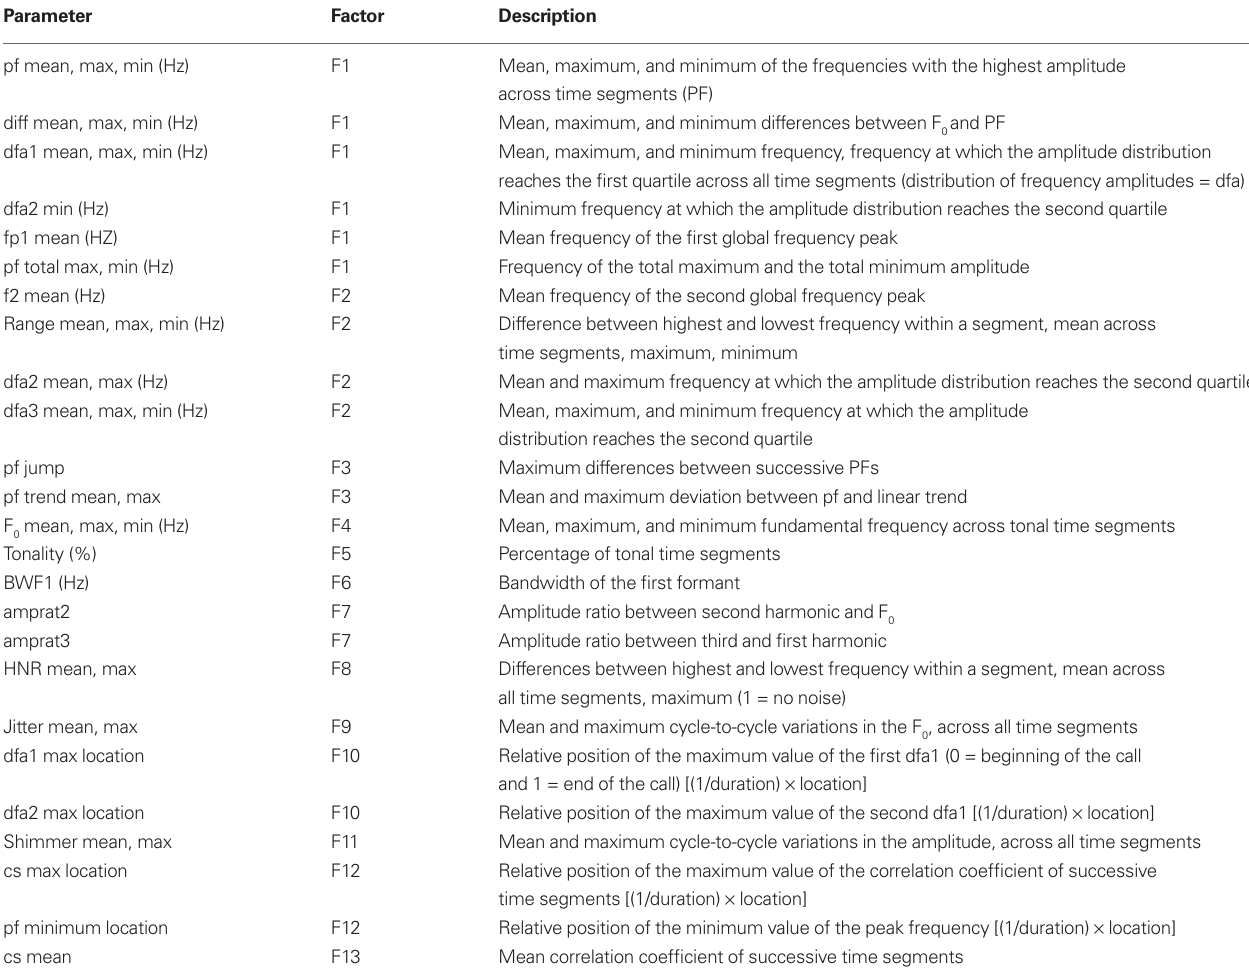
Table A1 | Abbreviations and descriptions of the acoustic parameters with high factor